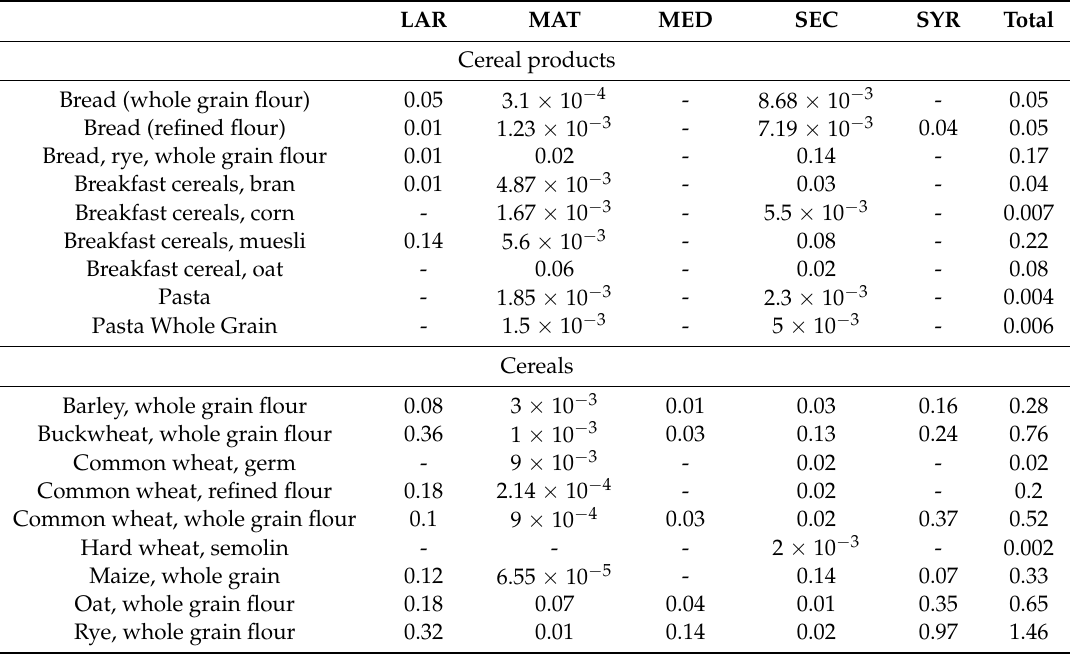
Table 3. Lignan content of cereals (mg/100g food) [18].